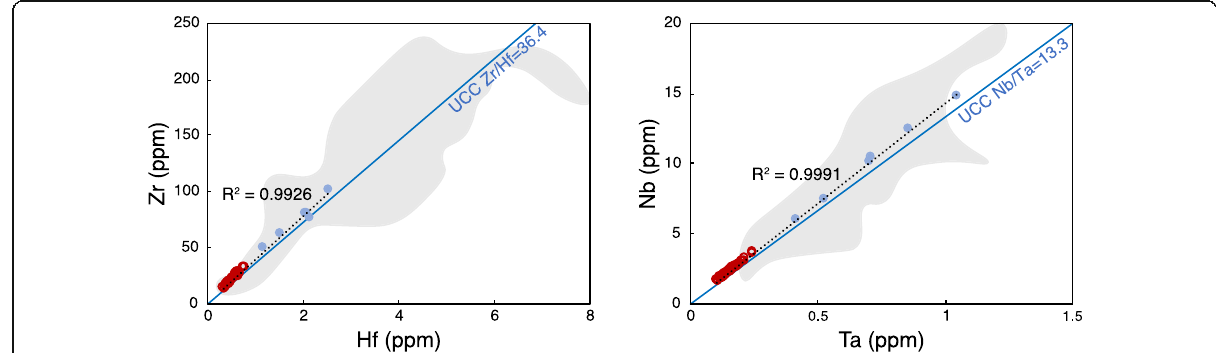
Fig. 6 Plots of Zr vs. Hf and Nb vs. Ta for chert (open red circles) and claystone (filled blue circles) samples. Compilation of modern deep-sea sediments (gray field; Plank and Langmuir 1998) are also shown for